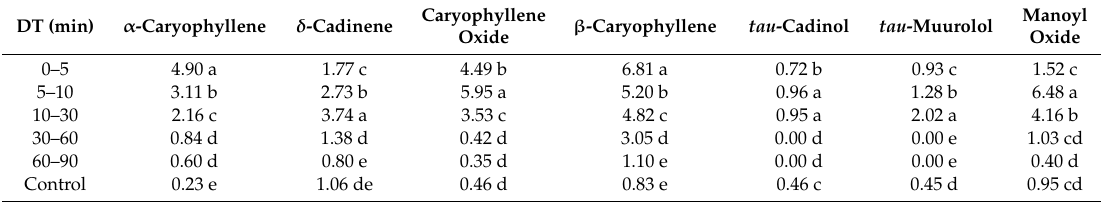
Table 5. Mean concentrations (%) of Ruta graveolens fruit EO ( α -caryophyllene, δ -cadinene, caryophyllene oxide, tau -cadinol, tau -muurolol, β -caryophyllene, manoyl oxide) obtained from the six distillation times (DT). Control = nonstop 0–90